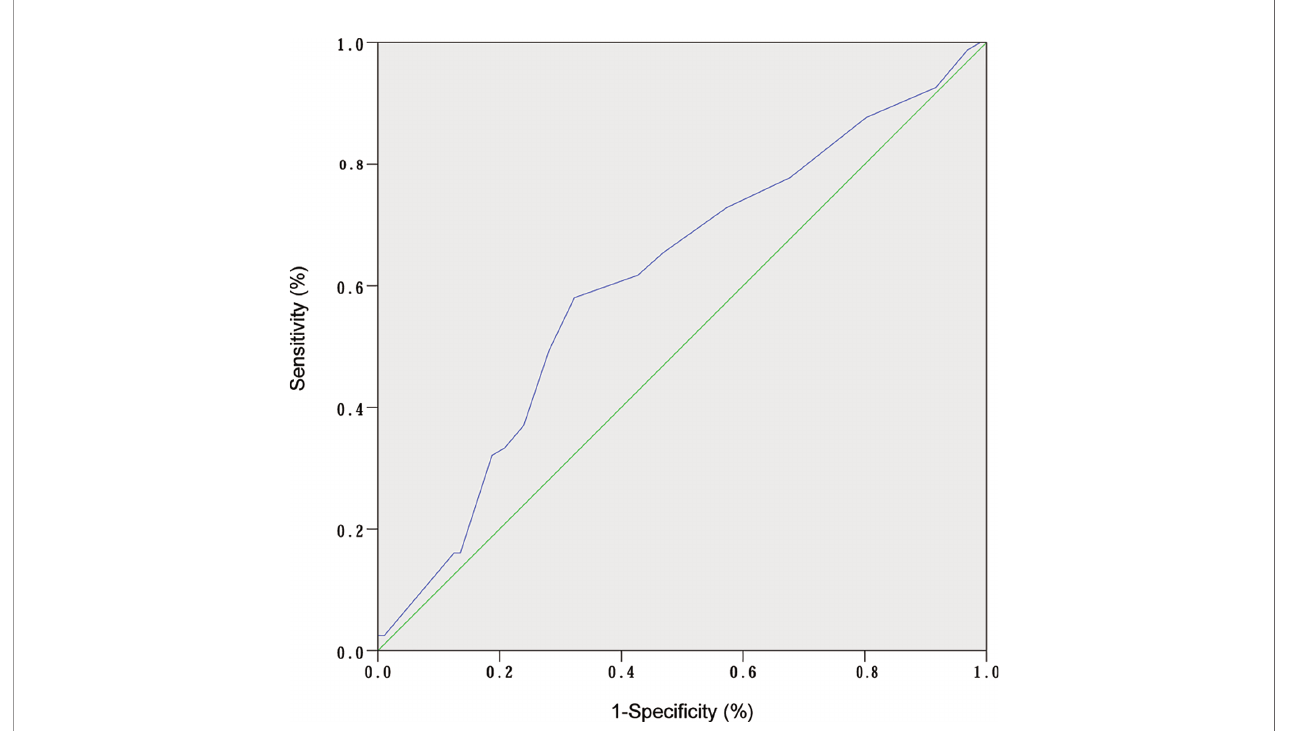
FIGURE 3 | ROC curve analysis of tumor size and CLN metastasis. (AUC:0.610; 95% CI: 0.526 – 0.694; P = 0.01).